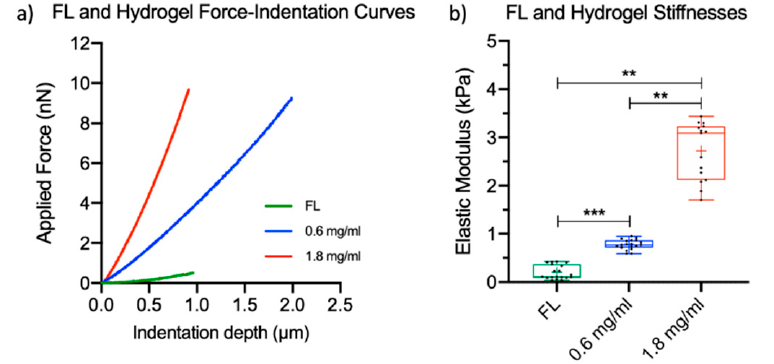
Figure 1. Elastic moduli of fetal liver (FL) tissue and fibrin hydrogels: ( a ) representative force-indentation curves of murine E14.5 FL tissue and fibrin hydrogels and ( b ) calculated Young’s moduli of FL tissue and fibrin hydrogels. Boxplots show the distribution of Young’s modulus with boxes representing the interquartile ranges, while the mean is represented by the plus sign. Dots represent the average values from the different areas. The mean elastic modulus of FL tissue was calculated using 19 randomly selected areas from 3 independent samples. The mean elastic modulus of the 0.6 mg/mL fibrin hydrogels was calculated from 19 randomly selected areas from 4 independent samples. For 1.8 mg/mL fibrin hydrogels, 15 randomly selected areas from 3 independent samples were used. Statistical analysis was performed with nested t-tests: ** p < 0.01 and *** p < 0.001.